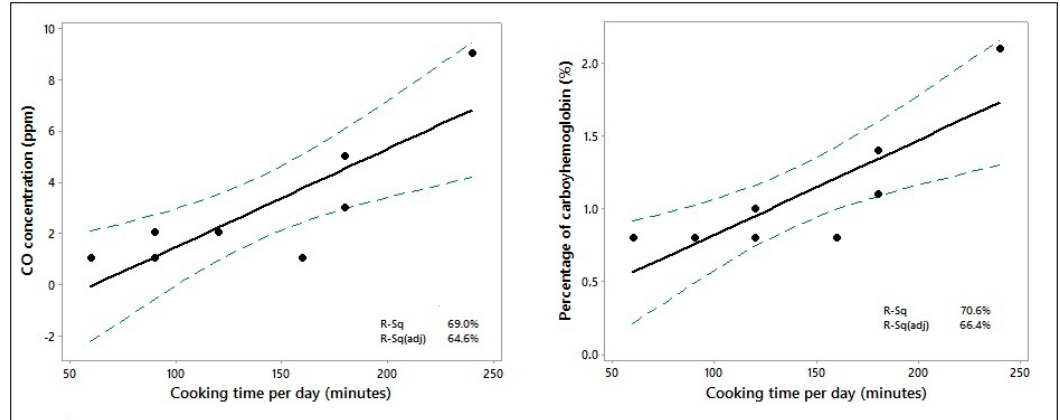
Figure 1. Time spent cooking in a kitchen without a chimney using wood fuel plotted against expired